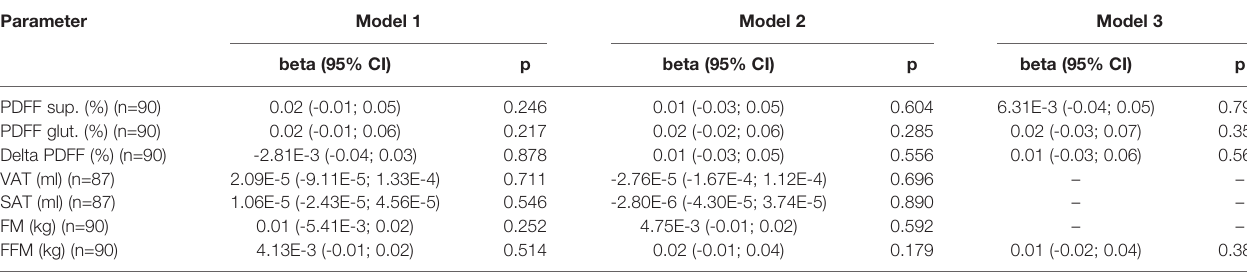
TABLE 4 | Per risk allele change of the FTO rs1421085 genotype and parameters of adipose tissue. Parameter